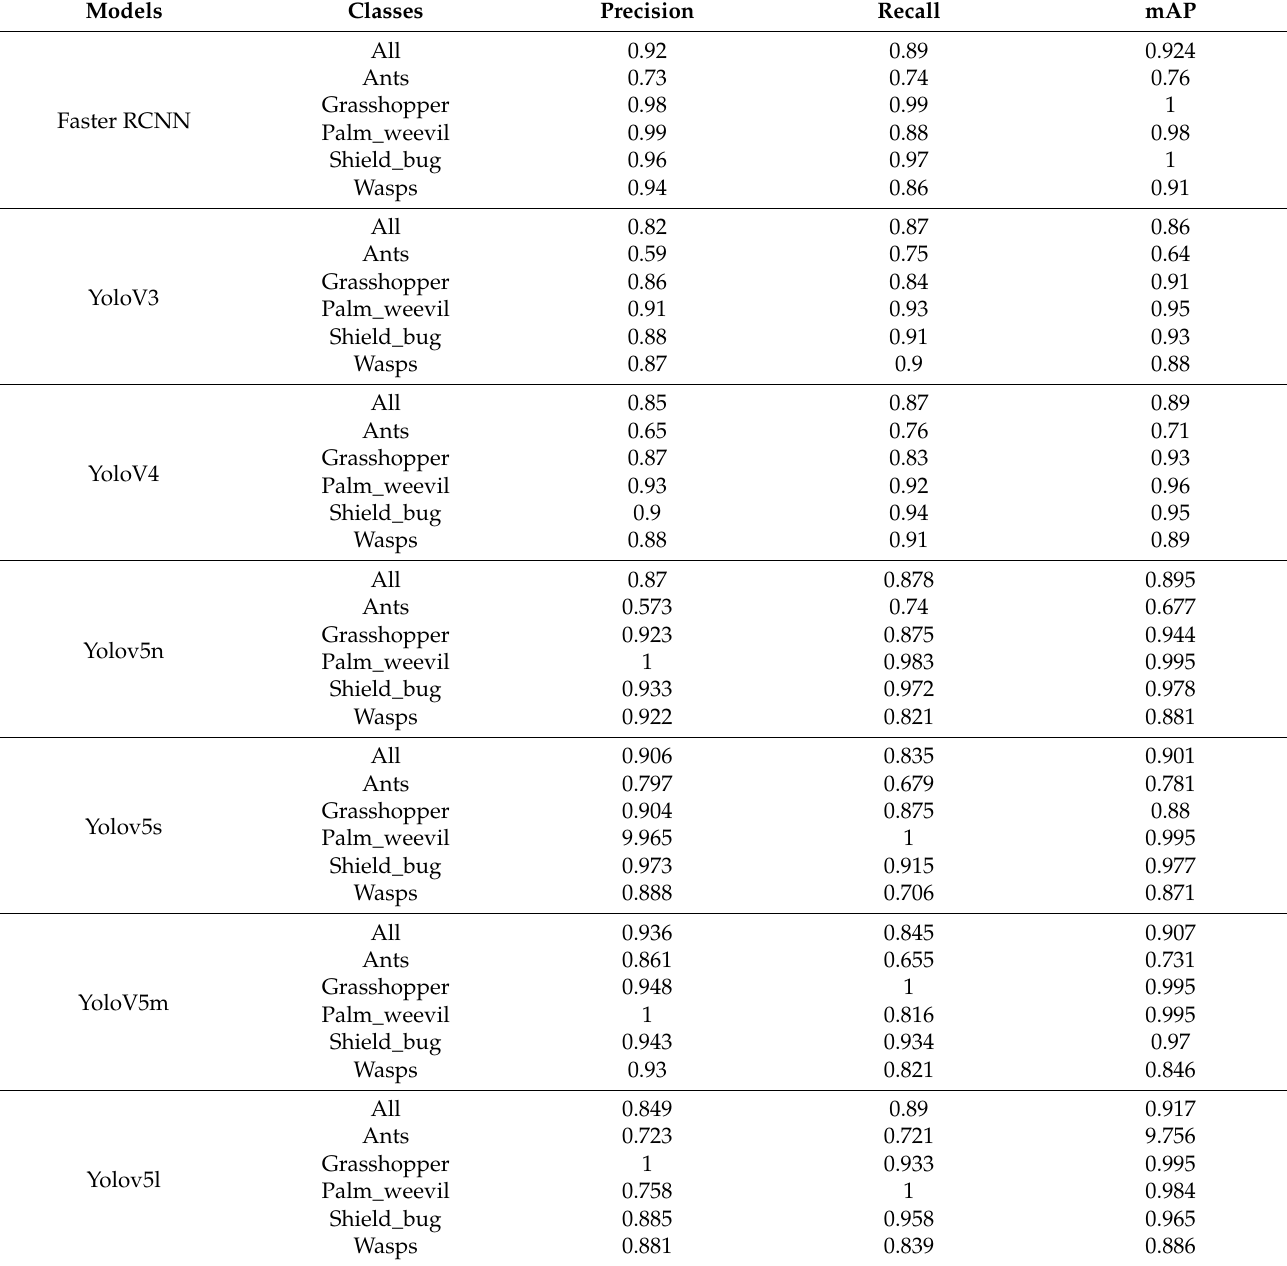
Table 2. Comparative analysis of the proposed model with various versions of the YOLOv5